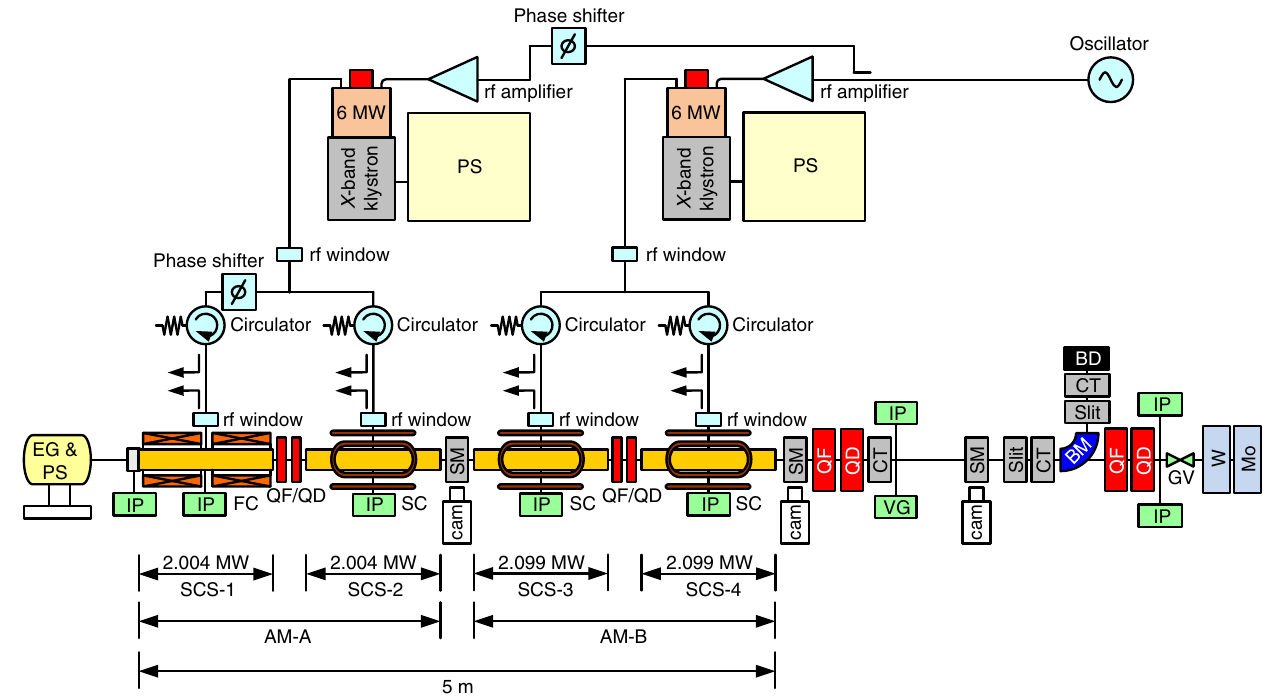
FIG. 2. Schematic representation of the X -band electron linear accelerator. The abbreviations are explained in Table I.